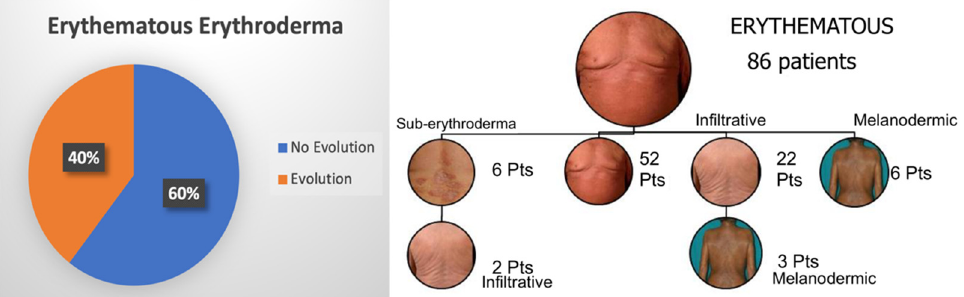
Figure 2. Percentage of erythematous erythrodermic patients who showed a clinical downgrading or evolution to infiltrative/melanodermic patterns.